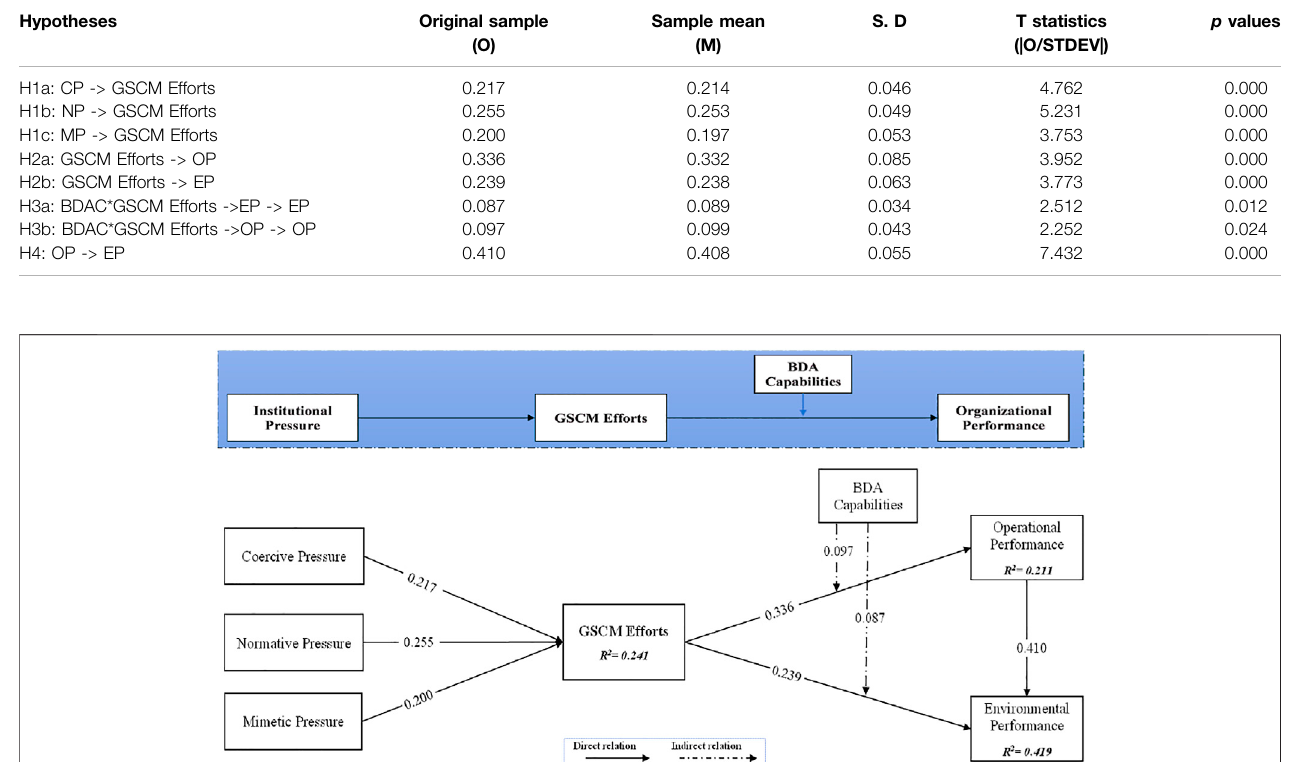
TABLE 6 | Results of hypotheses testing.